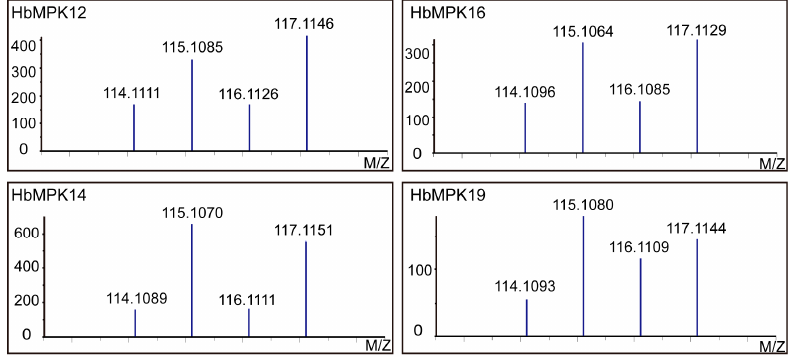
Figure 1. Proteomic validation of Hevea brasiliensis mitogen-activated protein kinases (HbMPK) expression patterns in rubber tree latex before and after ethephon treatment. Representative mass spectra indicate the signal intensities of isobaric tags for the validated MPKs. The spectra correspond to the peptides of “APELCGSFFSK”, “DYVHQLR”, “DLKPSNLLLNANCDLK” and “SFDFEQNALTEEQMK” for HbMPK12, HbMPK14, HbMPK16 and HbMPK19,